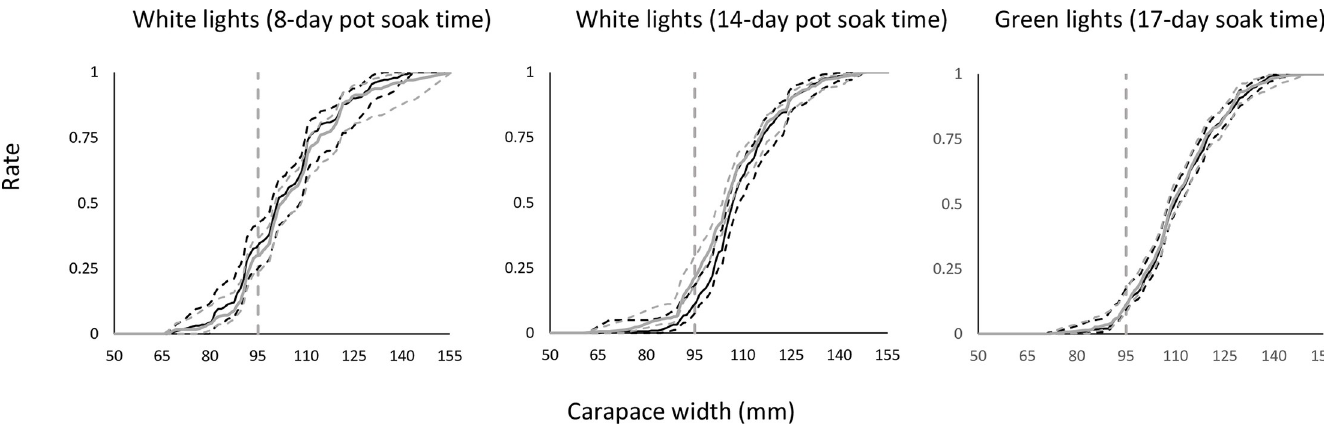
Fig 3. Cumulative size frequency distribution curves for baseline pots (grey line) and light experiments (black line) using (left to right): White lights (pot soak time 8 days), white lights (soak time 14 days), and green lights (soak time 17 days). The stippled curves are the 95% confidence limits. The grey stippled vertical line represents the minimum landing size (95 mm